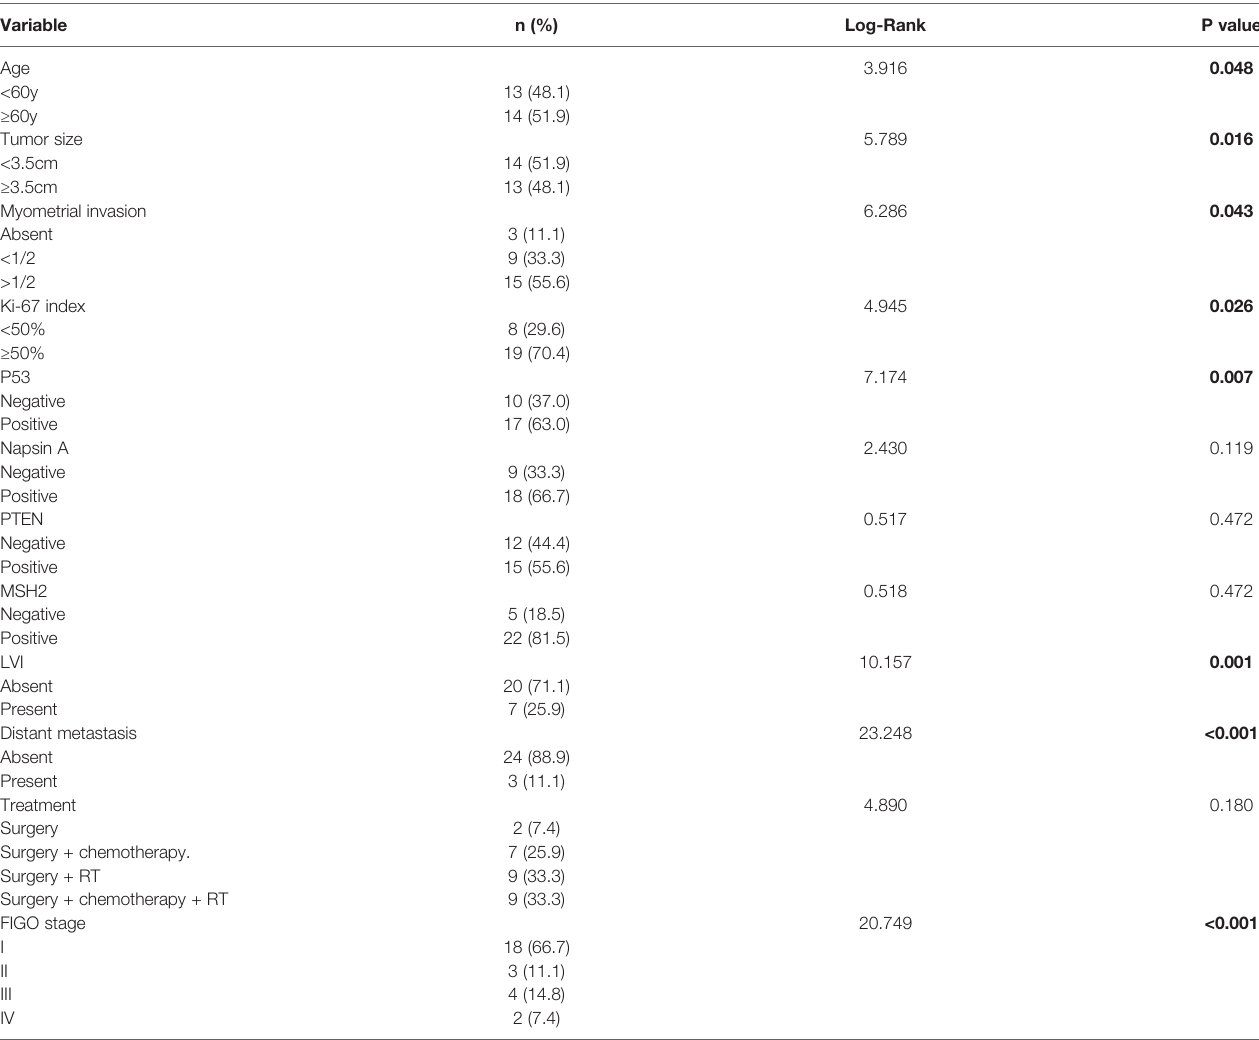
TABLE 3 | Univariate analysis of overall survival (n = 27).